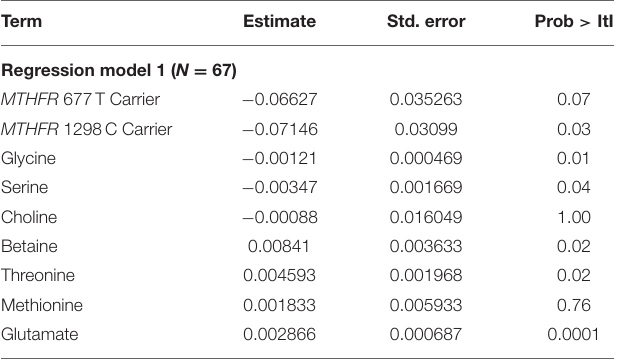
TABLE 2 | Least squares regression model parameters for initial input including all detected metabolites within one-carbon metabolism. Term